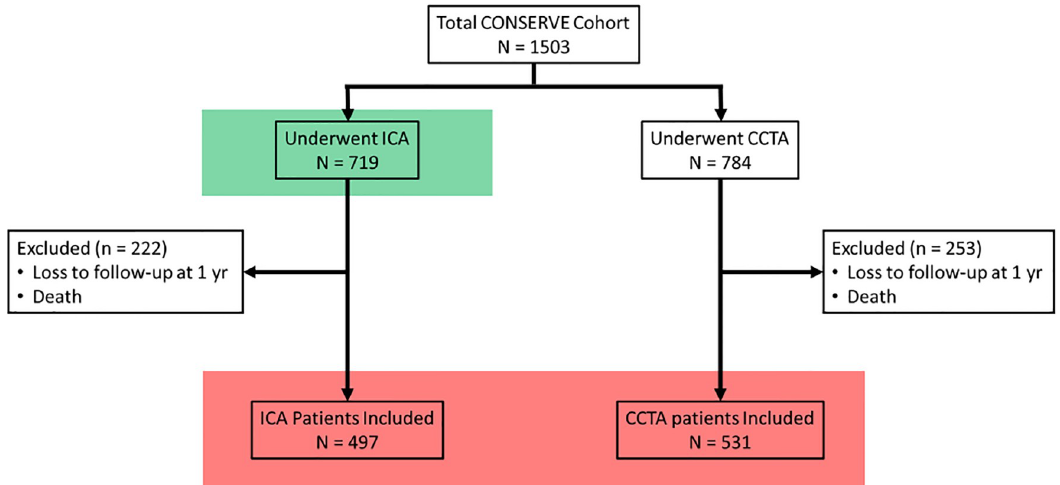
Fig 1. Patient selection. The cohort for revascularization analysis is in the red box, and the cohort for obstructive CAD prediction is in the green box. Abbreviations: CAD = coronary artery disease, CCTA = Coronary computed tomographic angiography, ICA = Invasive Coronary